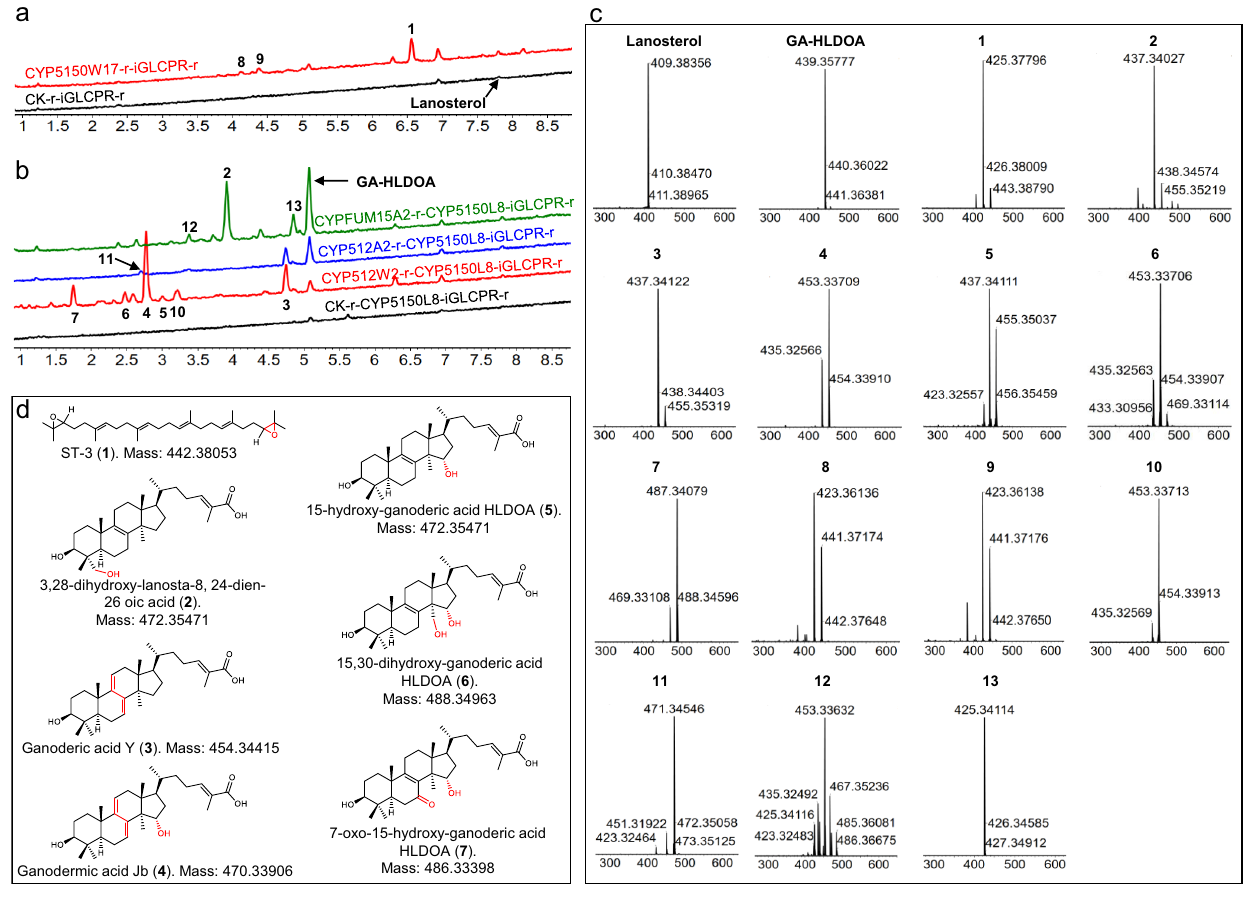
Fig. 3 | FunctionalCYP screening in strainsiGLCPR-rand CYP5150L8-iGLCPR-r. a UPLC analysis of extracts of strain CYP5150W17-r-iGLCPR-r (red line) and the control strain CK-r-iGLCPR-r (black line); b UPLC analysis of extracts of strain CYPFUM15A2-r-CYP5150L8-iGLCPR-r (green line), strain CYP512A2-r-CYP5150L8-